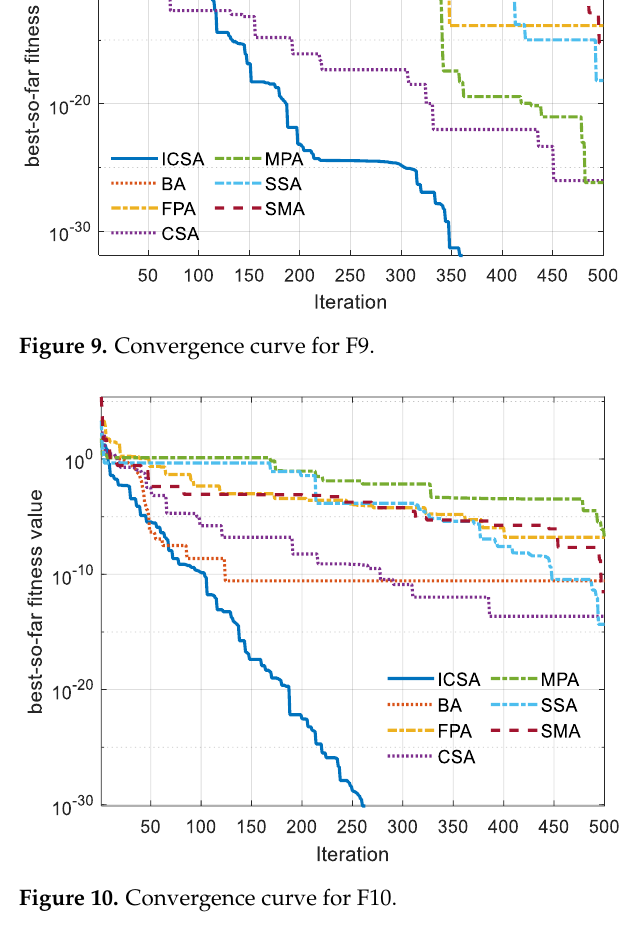
Figure 10. Convergence curve for F10.